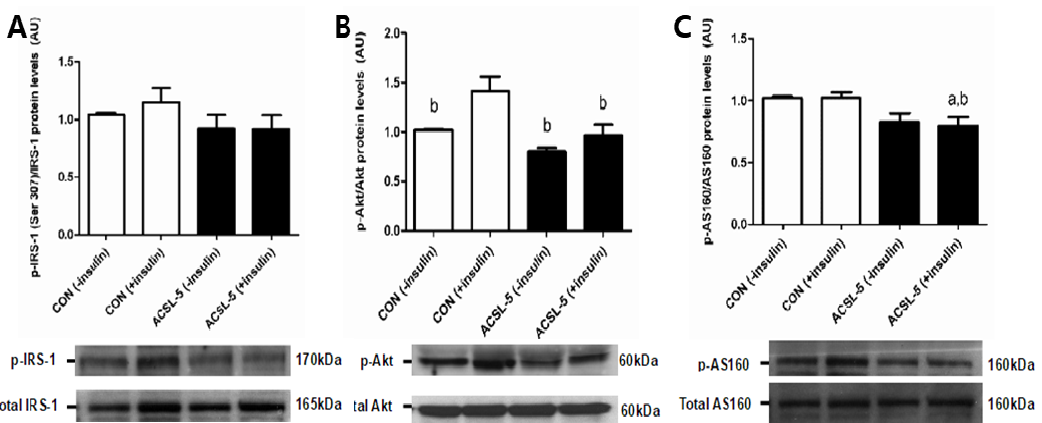
Figure 4. Effect of ACSL-5 overexpression on insulin signaling. Protein levels of phospho-/total IRS-1 ( A ), phospho-/total Akt ( B ), and phospho-/total AS160 ( C ) were measured using Western immunoblot analysis (open bar, control cells; closed bar, ACSL-5 transfected cells). Western blots and mean ( ± SEM) data (n = 6) in the absence or presence of insulin treatment were presented. a p < 0.05 versus non-insulin-treated control; b p < 0.05 versus insulin-treated control (CON).